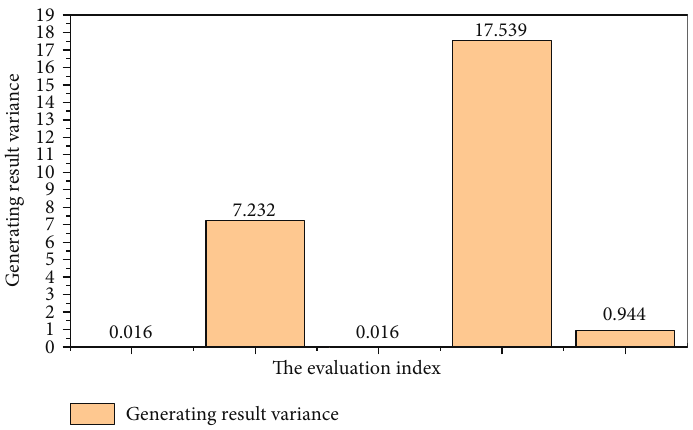
Figure 6: Comparison of the performance of real cases and generated results in the variance of generated results.